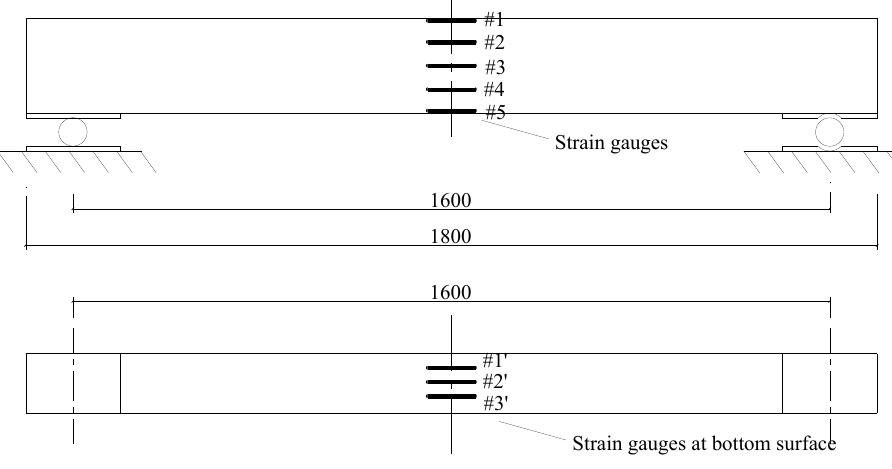
Figure 5. Plane cross-section assumption of the experimental beam. When the experimental load arrived at F = 4.5 kN, the measurements of the three strain gauges (#1’, #2’ and #3’) began to fluctuate. A tiny crack was visually found in the region near to these gauges. It was predicted that this crack was caused by the concrete defects during casting and curing, because it grew slowly during the test. The fluctuation became more serious for the side strain gauges of #1’, #3’ and #5 as the load reached around 5.5 kN. Their measured strains showed reductions at their points of inflection. At this moment, the tensile stress inside the concrete was partly released owing to the cracking of the concrete defects. The missing tensile stress was taken over by the tensile steel bars. Therefore, the strains nearby the defects decreased, resulting in a magnitude reduction of #1’, #3’ and #5. Their strains restarted increasing after F = 6 kN. Such a serious fluctuation was not observed in #2’ because the defect cracks mainly concentrated at the corners of the cross-sections. When the load reached around 7 kN, a visual main crack appeared at the beam bottom and grew rapidly with the increase of the load. The measured strains also went so fast that they suddenly intersected the interval envelopes, as shown in Figure 6. The main crack defined the cracking load. Therefore, the cracking load was determined to be 7 kN, which was close to the analytical solution of